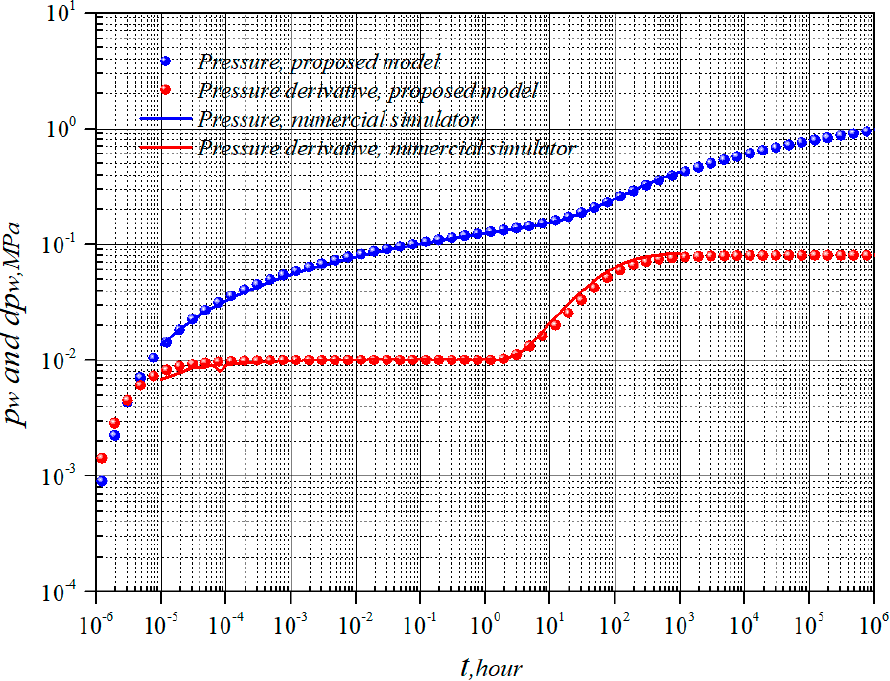
Figure 4. Comparison of the proposed model and numerical simulator for a radially composite model. Table 3. The reservoir, well, and gas properties in the method verification.